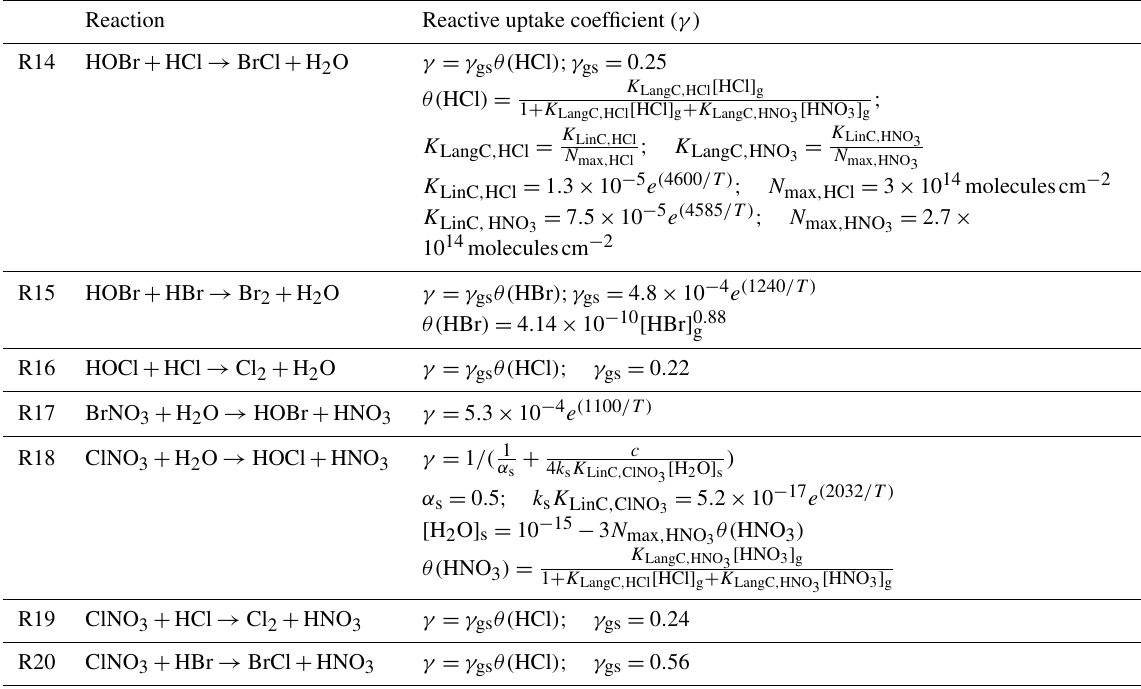
Table 3. Heterogeneous halogen reactions on ice crystals a .